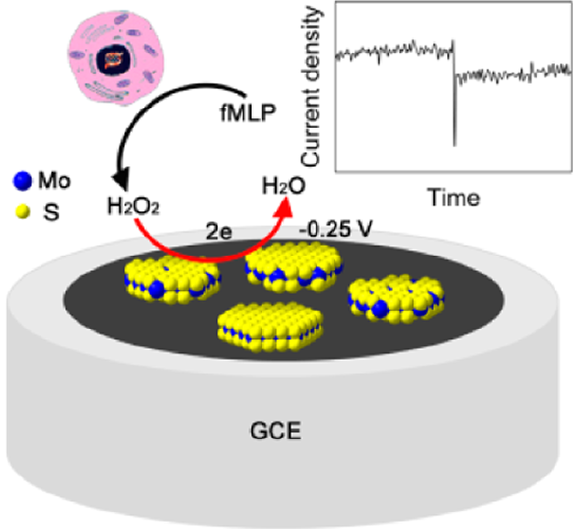
Figure 9. Schematic representation of a hydrogen peroxide H 2 O 2 biosensor based on MoS 2 nanopar- ticles. With permission from [82].